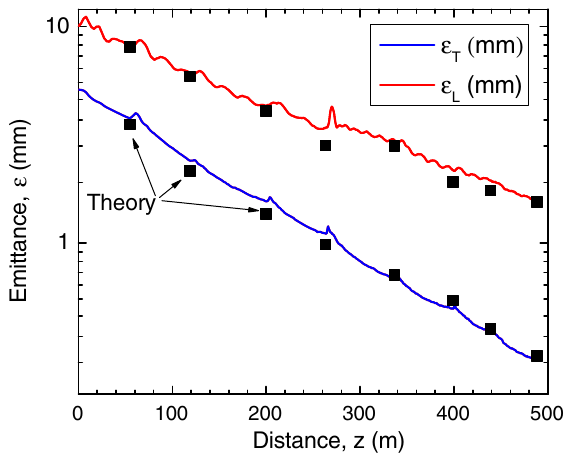
FIG. 10. Simulation results and theoretical predictions of the performance of a rectilinear 6D cooling channel for a muon collider. The plot shows the evolution of the normalized rms emittances as a function of distance along the channel after recombination. At z ¼ 488 m the transmission is 40% with muon ¼ 0 . 28 mm decays, while the final simulated emittances are ε sim T ¼ 1 . 57 mm. The squares are theoretical calculations and ε sim L from Eq. (9). The agreement between theory and simulation is within 18%.